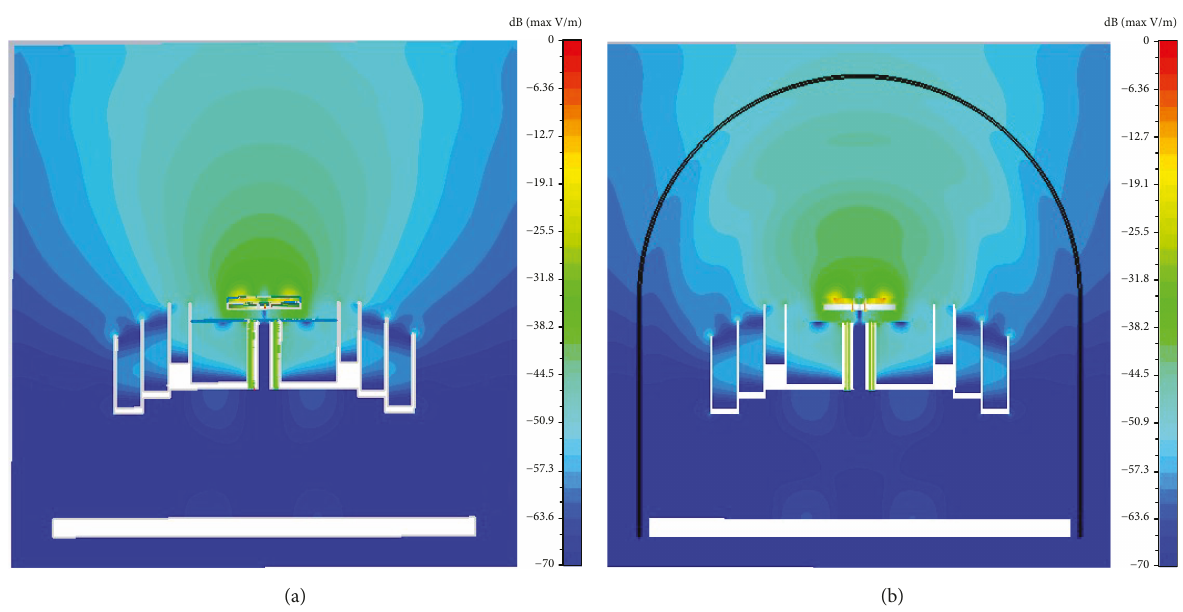
Figure 6: Comparison of simulated electric fi led distribution near the antenna at 2.5GHz (a) without radome and (b) with radome.